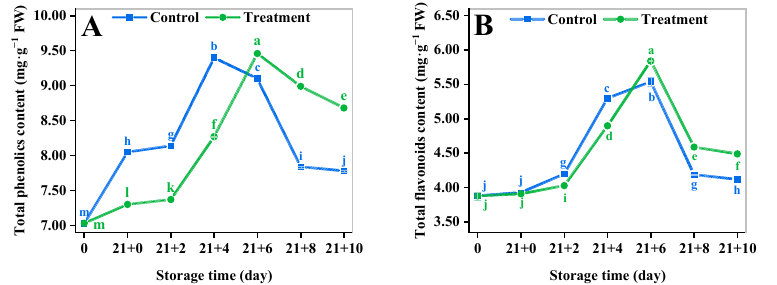
Figure 4. Effect of different storage methods on TPC ( A ) and TFC ( B ) of yellow peach. Vertical bars represent standard deviations. Different letters represent statistical differences ( p < 0.05).